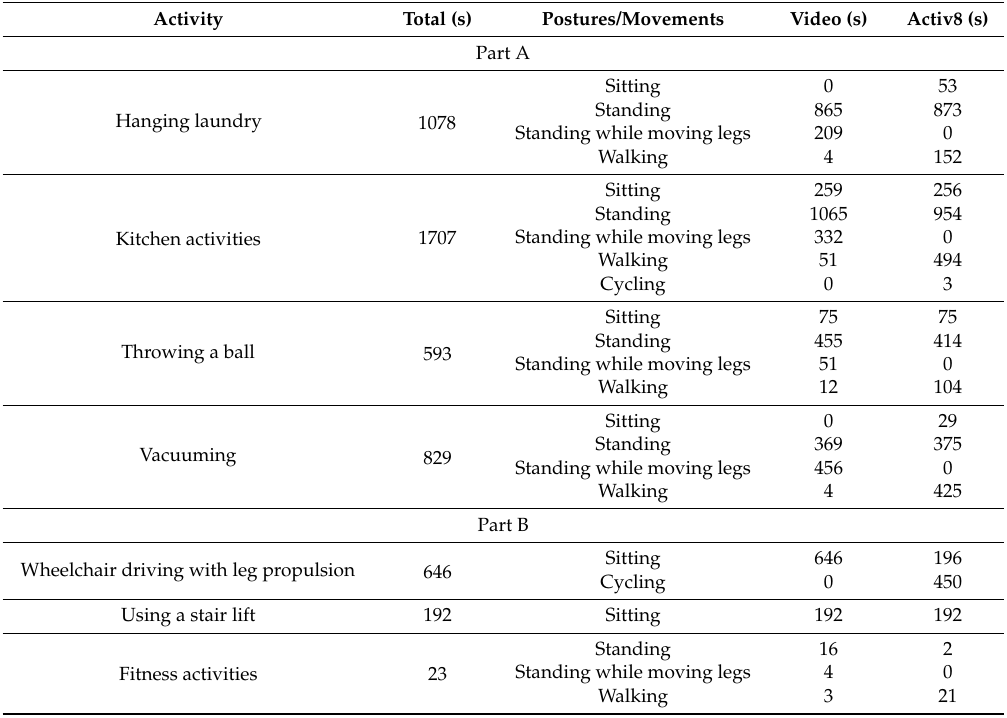
Table 3. The registered video and the Activ8 time of daily-life activities (Part A) and free-choice activities (Part